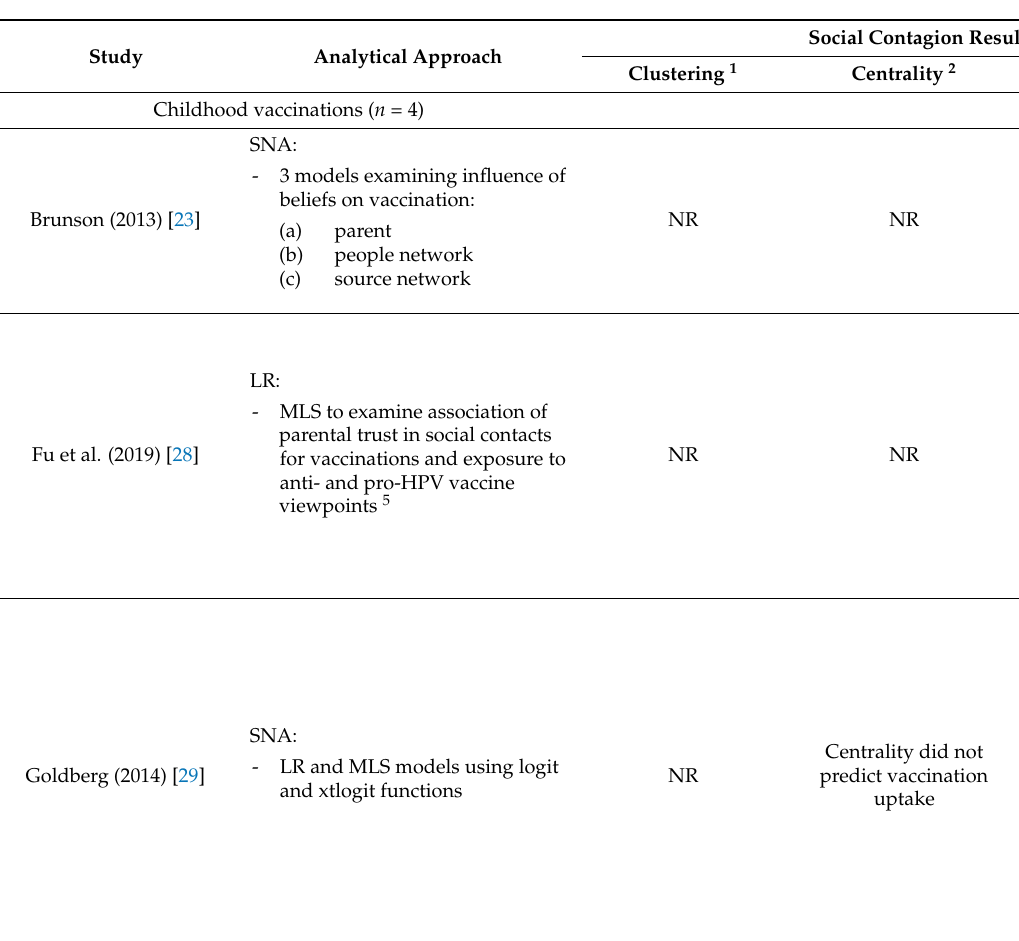
Table 2. Results of studies on the influence of social network members on individuals’ vaccination attitudes and